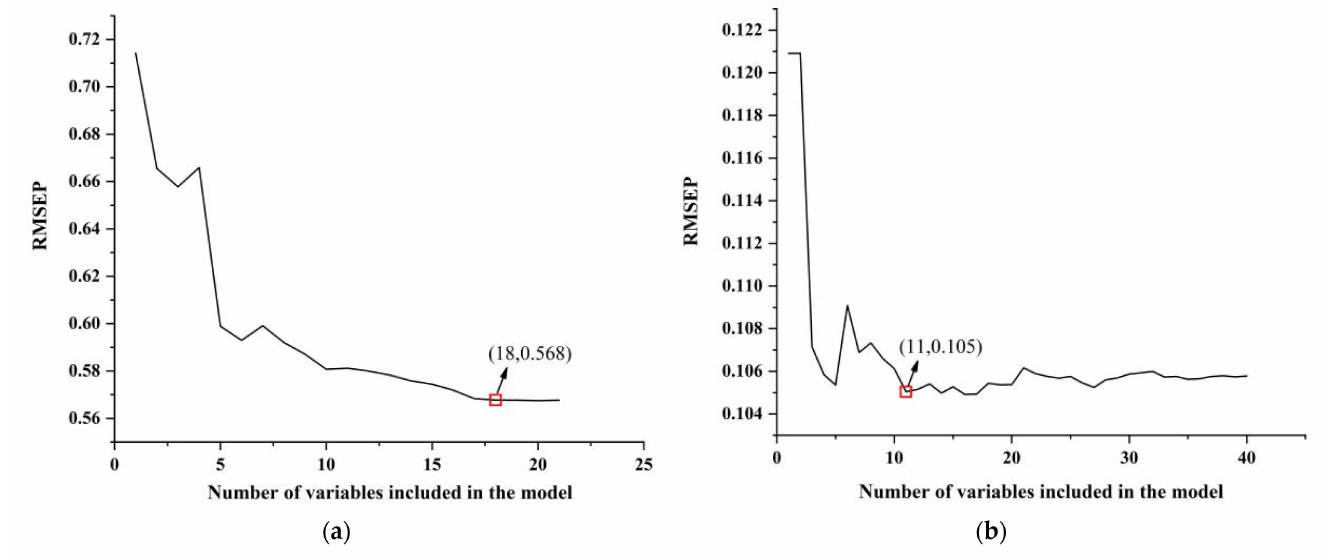
Figure 7. SPA algorithm to select pear soluble solids content (SSC) ( a ) and acidity (pH) ( b ) fea- ture variables.